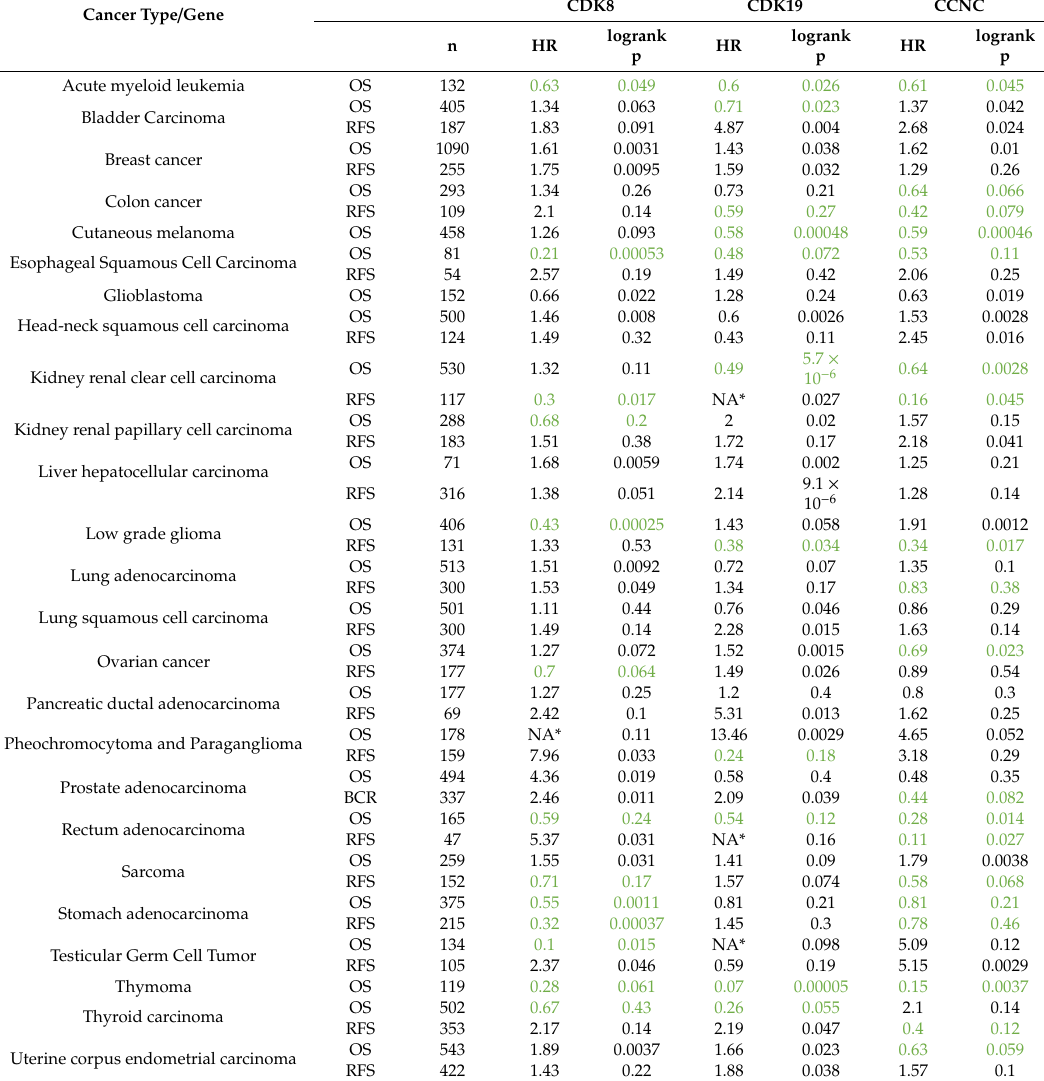
Table 1. Correlations of CDK8 / CDK19 / CCNC expression with patient survival in di ff erent types of cancer (OS, overall survival; RFS, relapse-free survival; BCR, biochemical relapse). The correlations for most cancers were derived using Kaplan-Meyer plotter Pan-Cancer RNA-Seq dataset and for a subset of cancers (AML, colon, melanoma, glioblastoma, glioma, prostate) from the available RNA-Seq data as described in Materials and Methods. The hazard ratio (HR) and p values are in black when the gene expression correlates with shorter survival and in green when it correlates with longer survival. p values < 0.05 are boldfaced. The p values do not include correction for multiple hypothesis testing.